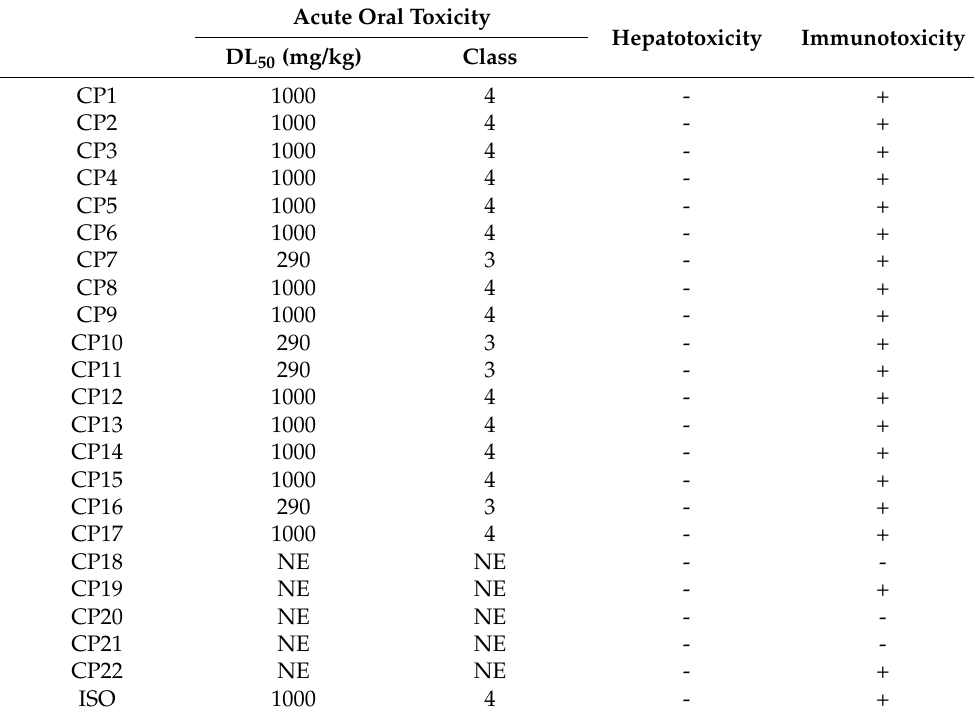
Table 3. Toxicity of isoleutherin and